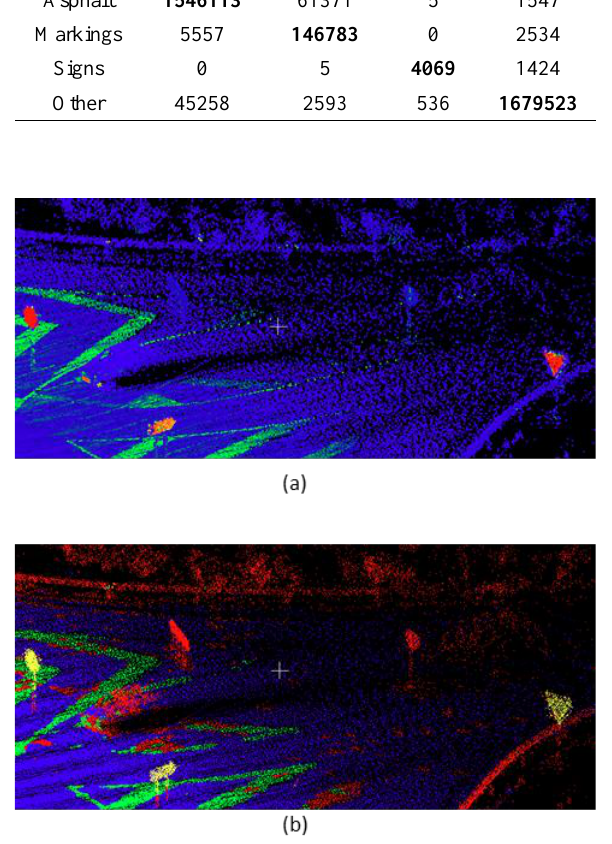
Figure 8. Road sign confusion illustration in a complex part of the test set. The model relies highly on intensity to classify road signs. (a) Point cloud visualization based on intensity (b) Classification of the model, with signs in yellow and other class as red.